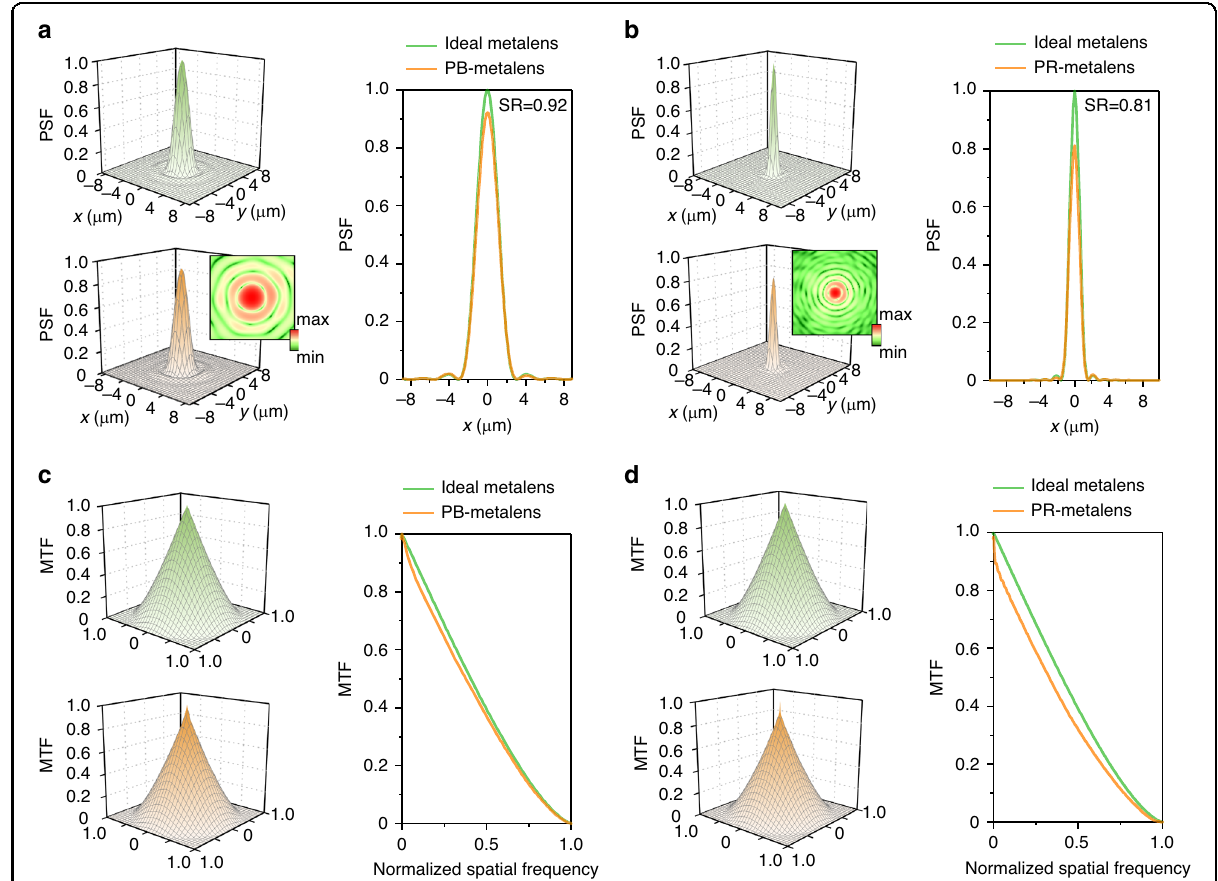
Fig. 5 Optical performance of metalenses. a PSF of the PB-metalens, and the SR is 0.92. The inset shows the logarithm of the measured PSF. b PSF of the PR-metalens, and the SR is 0.81. The inset shows the logarithm of the measured PSF. c MTF of the PB-metalens. d MTF of the